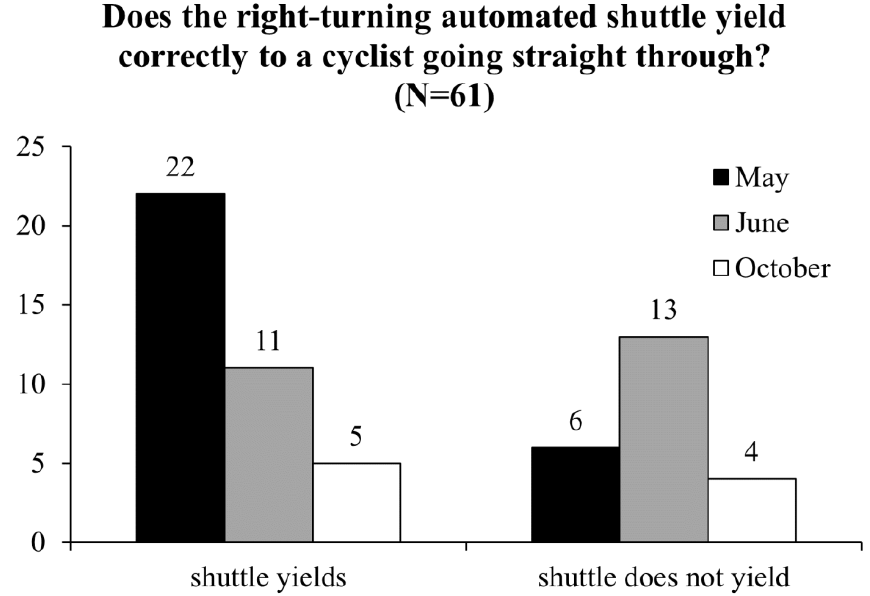
Figure 4 Interactions between right-turning autonomous shuttles and cyclists going straight